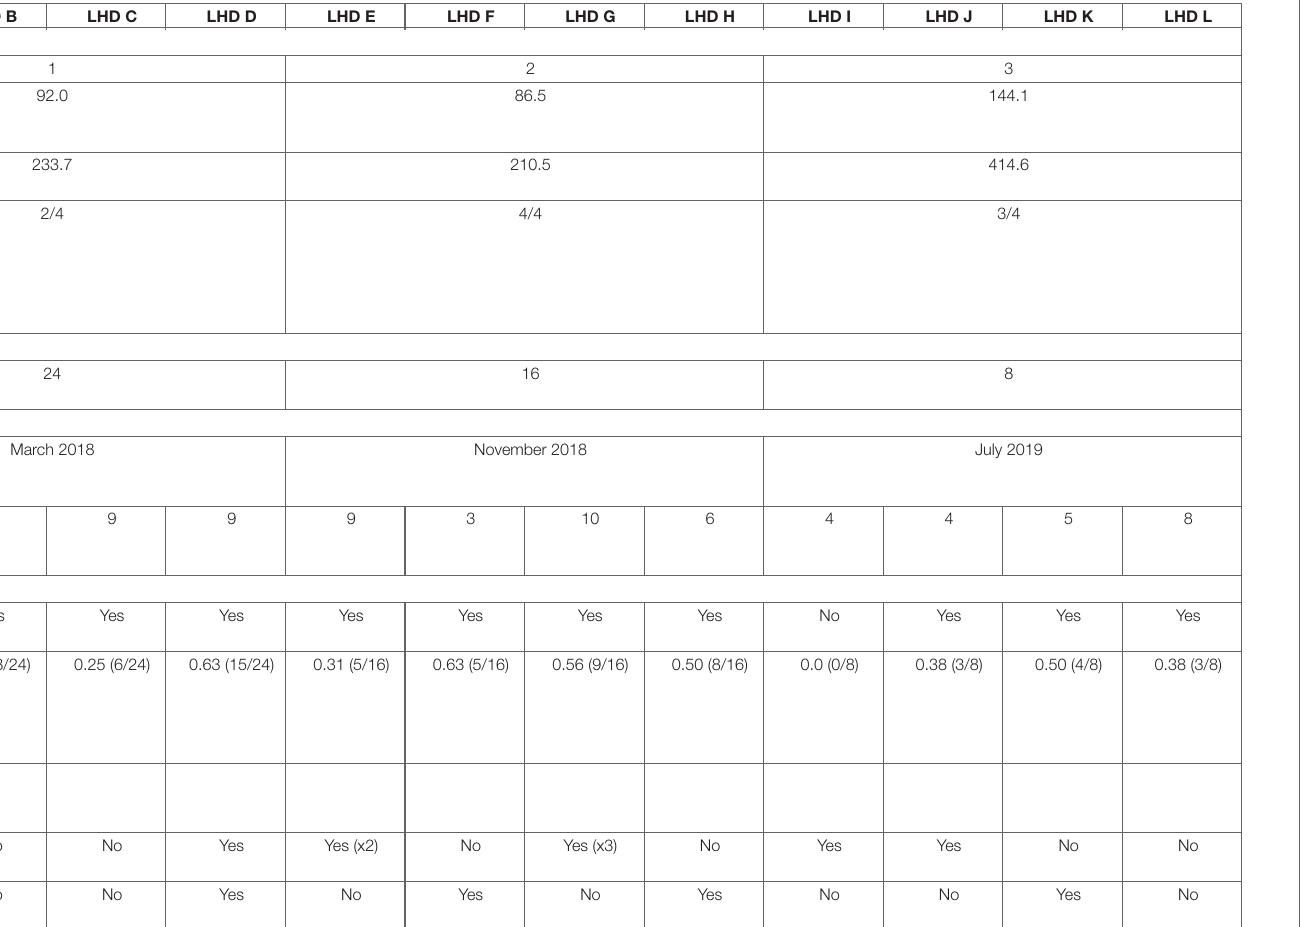
TABLE 1 | Intervention delivery description by group and unit (local health